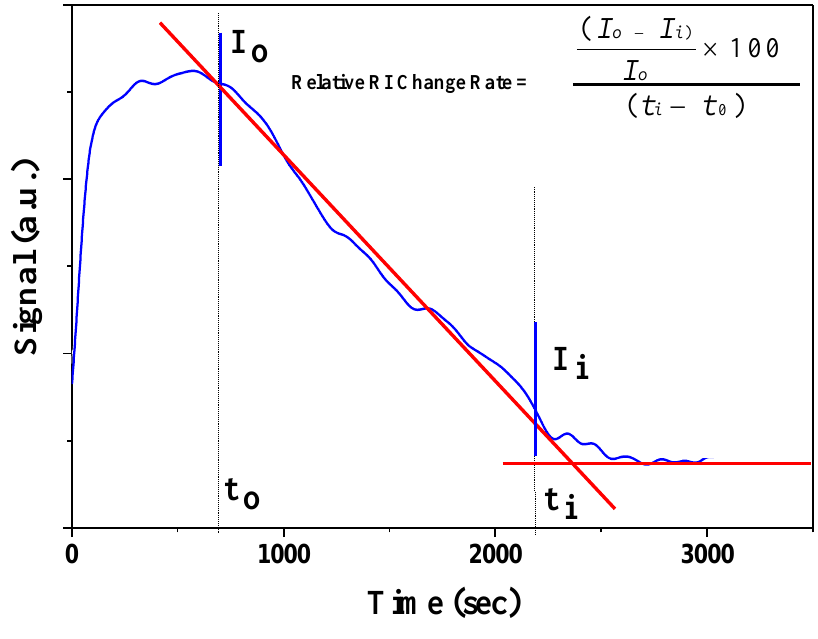
Figure 7. The calculation by numerical analysis of signals was represented as Relative RI Change